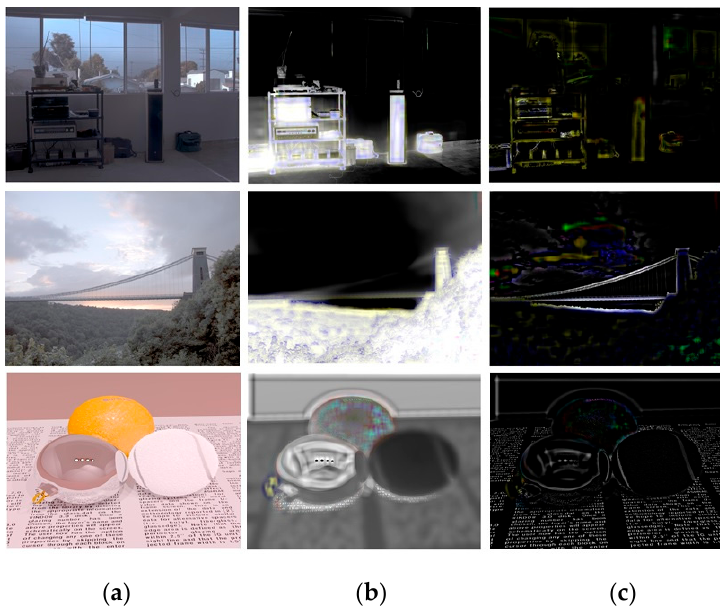
Figure 2. Attentional gaze and detail layer extraction: ( a ) original images, ( b ) attentional gaze extraction, ( c ) detail layer extraction.